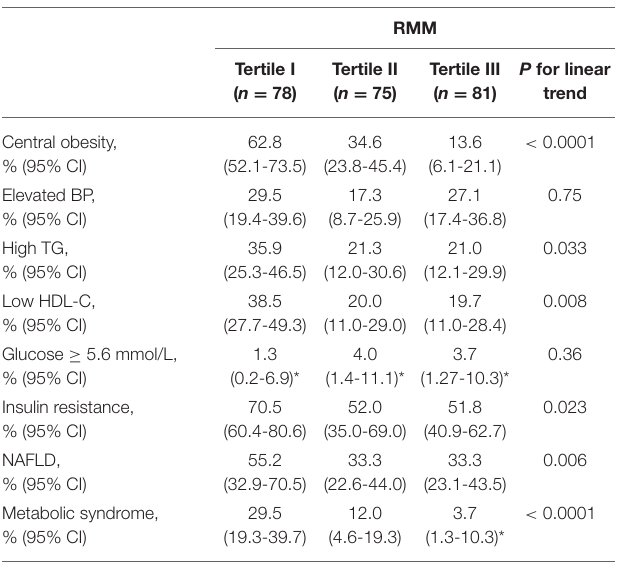
TABLE 4A | Adjusted odds ratio (95% CI) of the lowest tertile of RMM for NAFLD. RMM P for linear Tertile I Tertile II Tertile III ( n = 78) ( n = 75) ( n = 81) trend